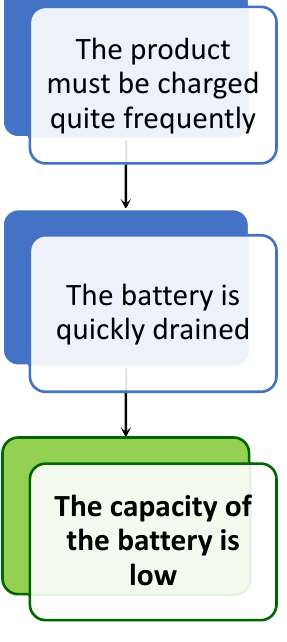
Figure 5. CEC analysis for constraint 2.